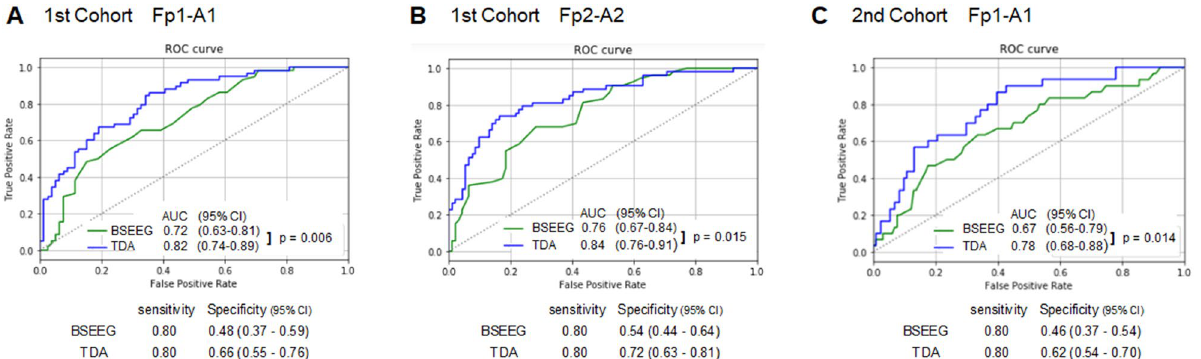
Figure 3. ( A ) ROC based on signals obtained from Fp1-A1 from the first cohort (58 delirium cases and 79 controls), ( B ) ROC based on signals obtained from Fp2-A2 from the first cohort (53 delirium cases and 92 controls), and ( C ) ROC based on signals obtained from Fp1-A1 from the second cohort (30 delirium cases and 131 controls). AUCs, DeLong’s test results, and specificities when sensitivities were set for 0.80 are